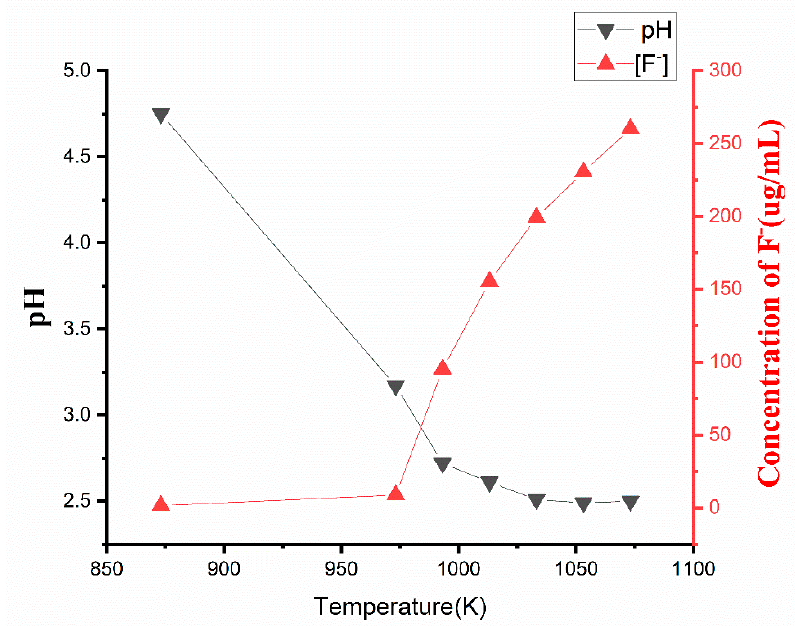
Figure 7. Relationships between pyrolysis temperature, pH and [F − ].